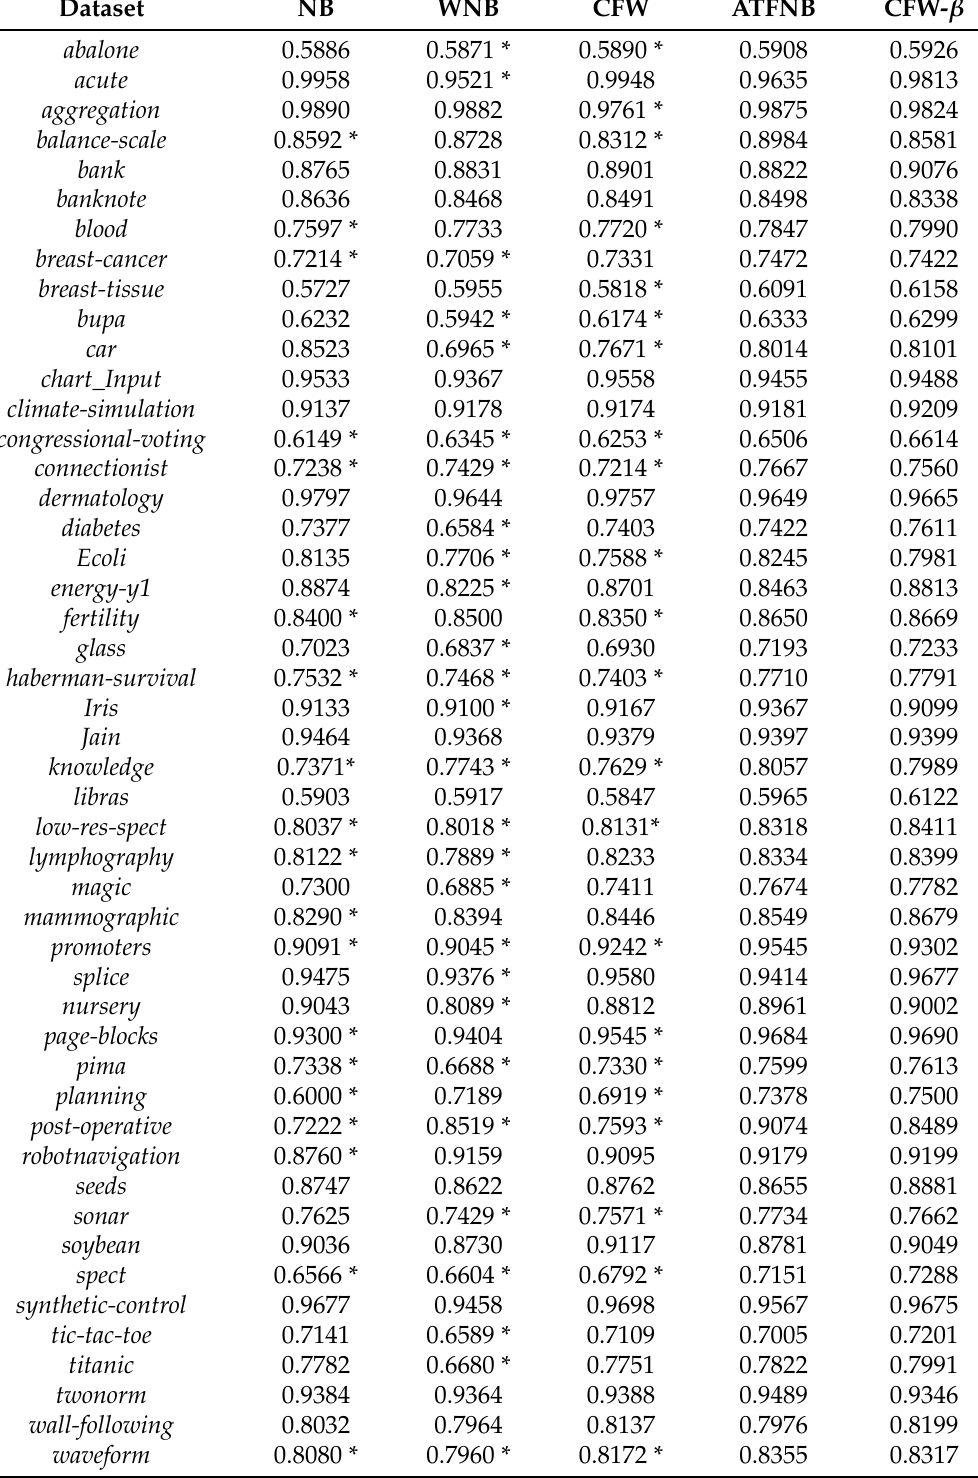
Table 5. Classification accuracy comparisons for ATFNB versus NB, WNB, CFW, CFW- β on UCI